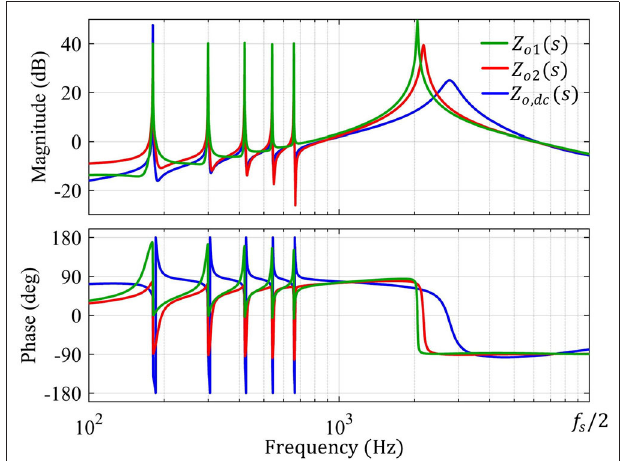
FIGURE 13 | Converter output impedance Z o ( s ) with K 3 100 (cid:127) , K 3 100 (cid:127) , K 5 100 (cid:127) , K 7 100 (cid:127) , K 9 = = = = ω B ,5 ω B ,7 ω B ,9 ω B ,11 90 (cid:127) , ω B ,3 0.5 rad/s, R vir = = = = = ω b 12000 π rad/s: Z o 1 ( s ) using (20) with converter-side current feedback and = Z o 2 ( s ) using (21) with grid-side current feedback.